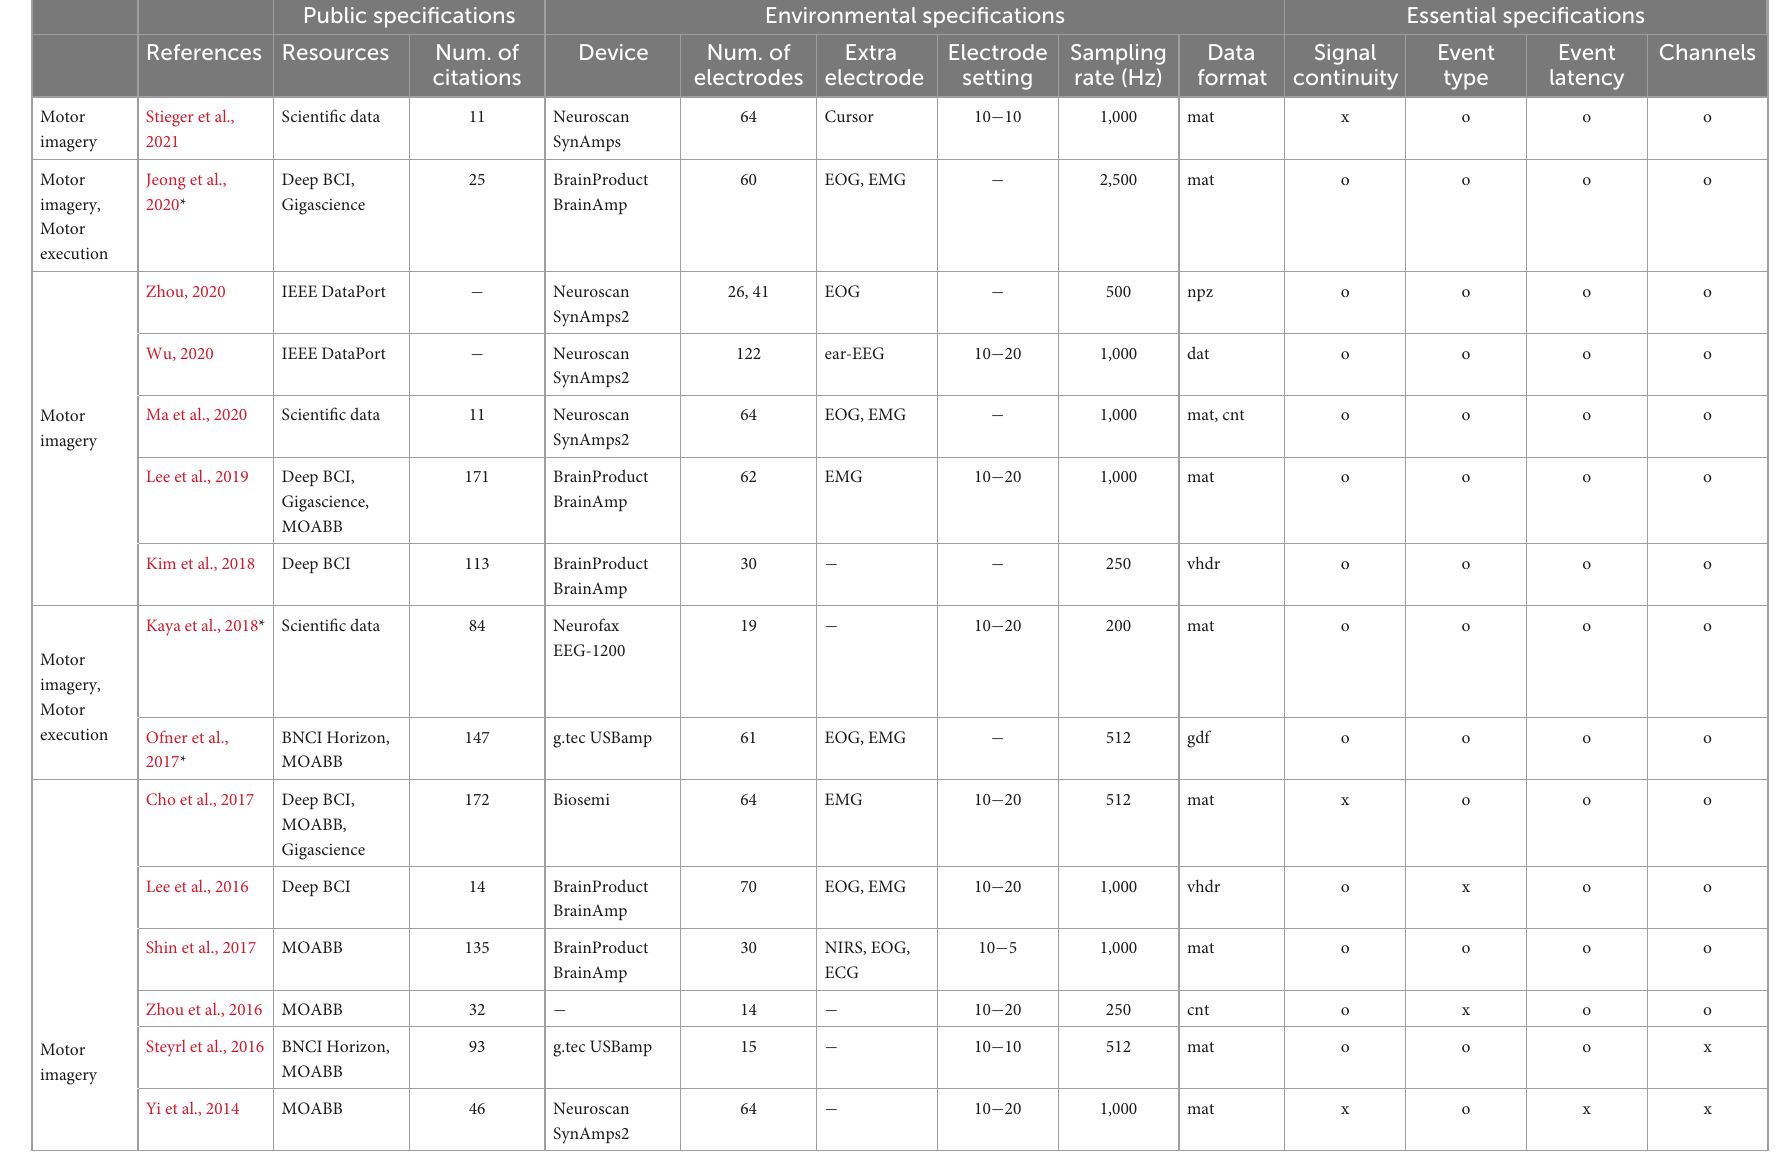
TABLE 1 Public and environmental specifications of motor imagery/execution datasets (–: no information